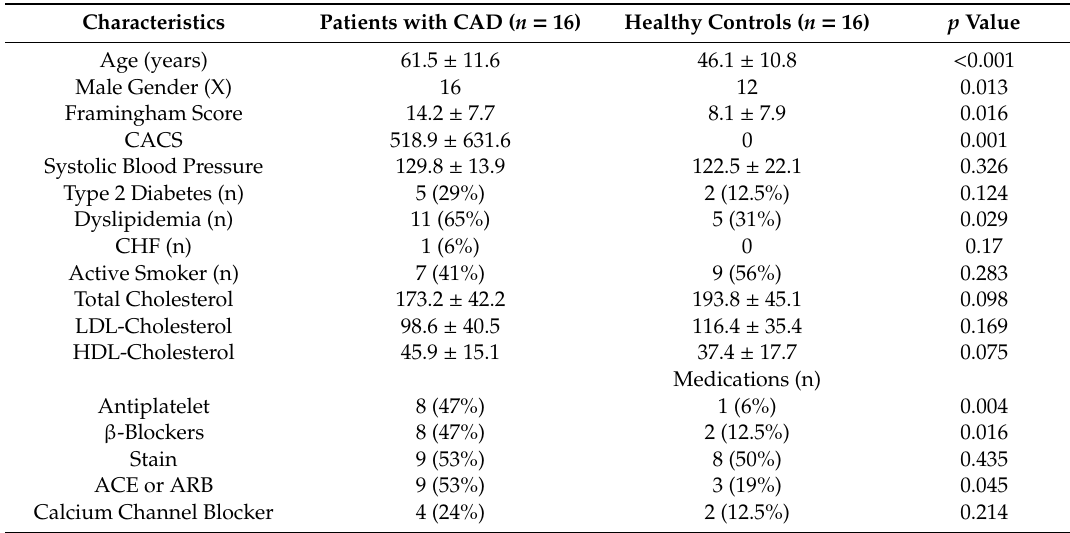
Table 2. Clinical Characteristics of Patients with CAD and Healthy Controls.